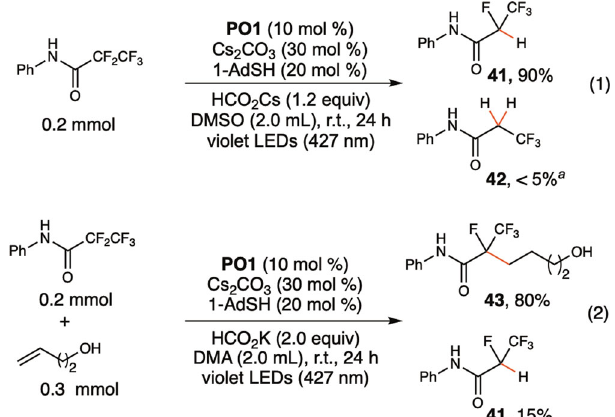
Fig. 6 Hydrode fl uorination and de fl uoroalkylation of penta fl uoroethyl group. Yields of isolated products. a Yield measured by 1 H-NMR using diphenylmethane as an internal